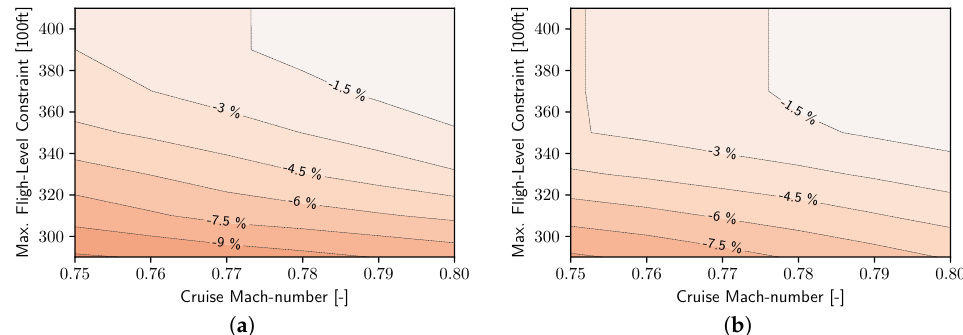
Figure 13. Total propulsion efficiency difference in mid-cruise for PtL concept D261+SAF ( a ) and LH2 concept D261+H2 ( b